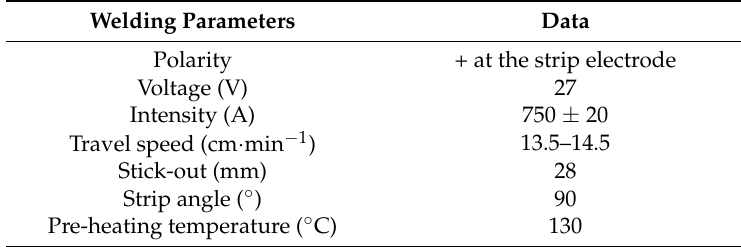
Table 2. SAW welding